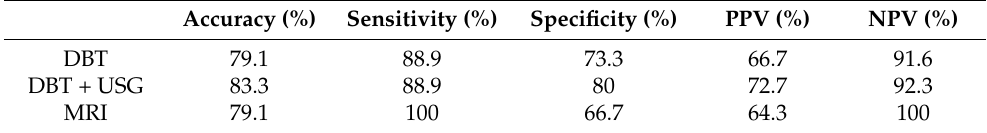
Table 4. Accuracy, sensitivity, specificity, PPV and NPV for DBT, DBT + USG and MRI. Accuracy (%) Sensitivity (%) Specificity (%) PPV (%) NPV (%) DBT 79.1 88.9